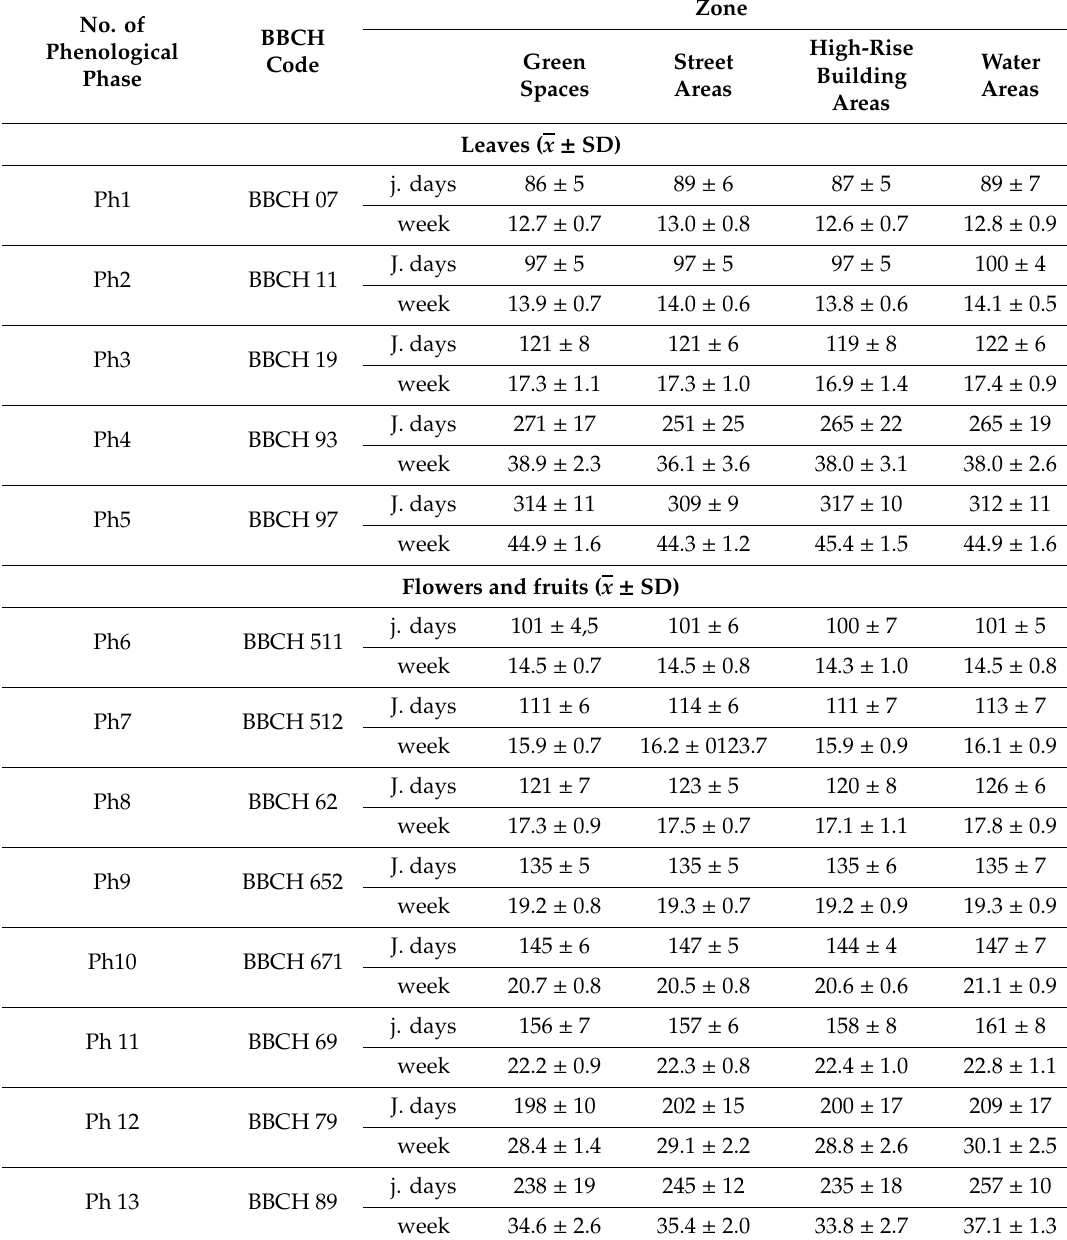
Table 6. Average date ( x ) and standard deviation (SD) of the occurrence of individual phenological phases depending on the form of land cover [in Julian days and